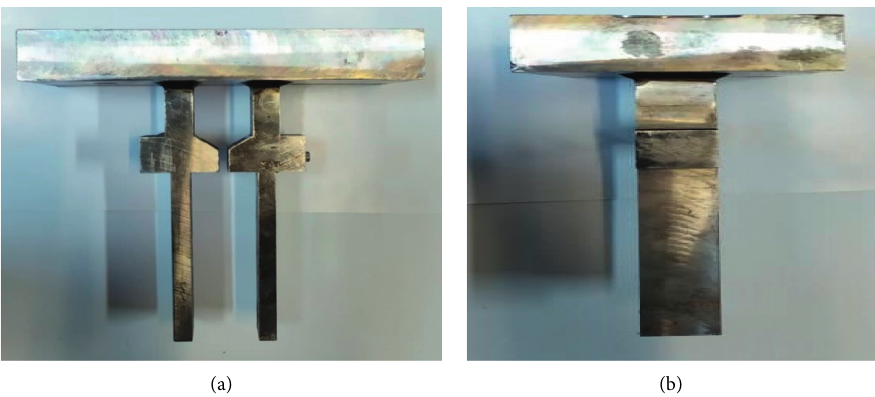
Figure 4: Laboratory sample-experimental test: (a) direct view; (b) side view.